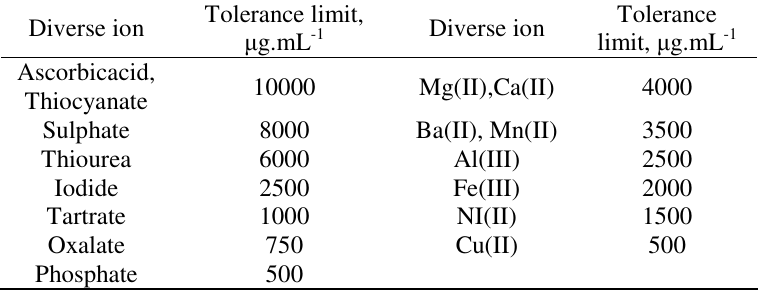
Table 1. Tolerance limit of diverse ions in the determination of